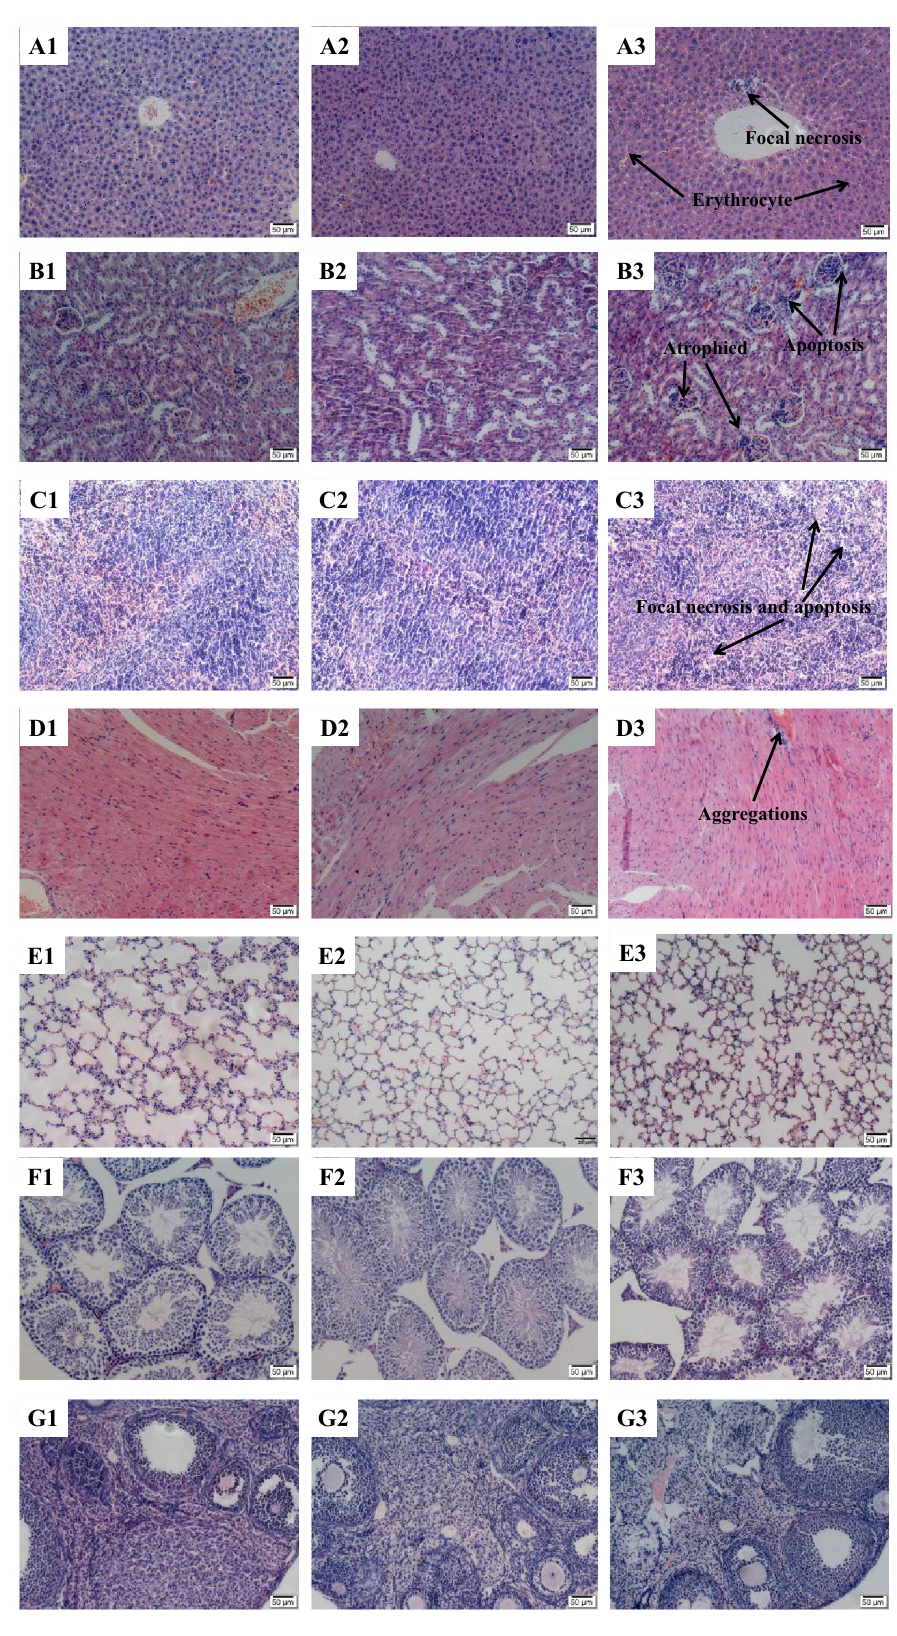
Fig. 3 Histopathological results of seven organs in mice after oral administration